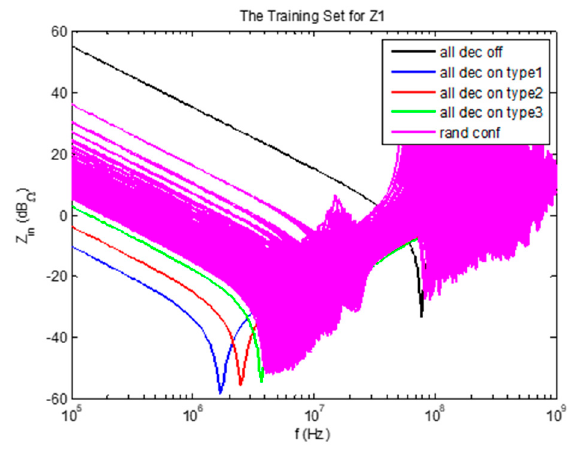
Figure 5. TS for one of the ports (Port 1).